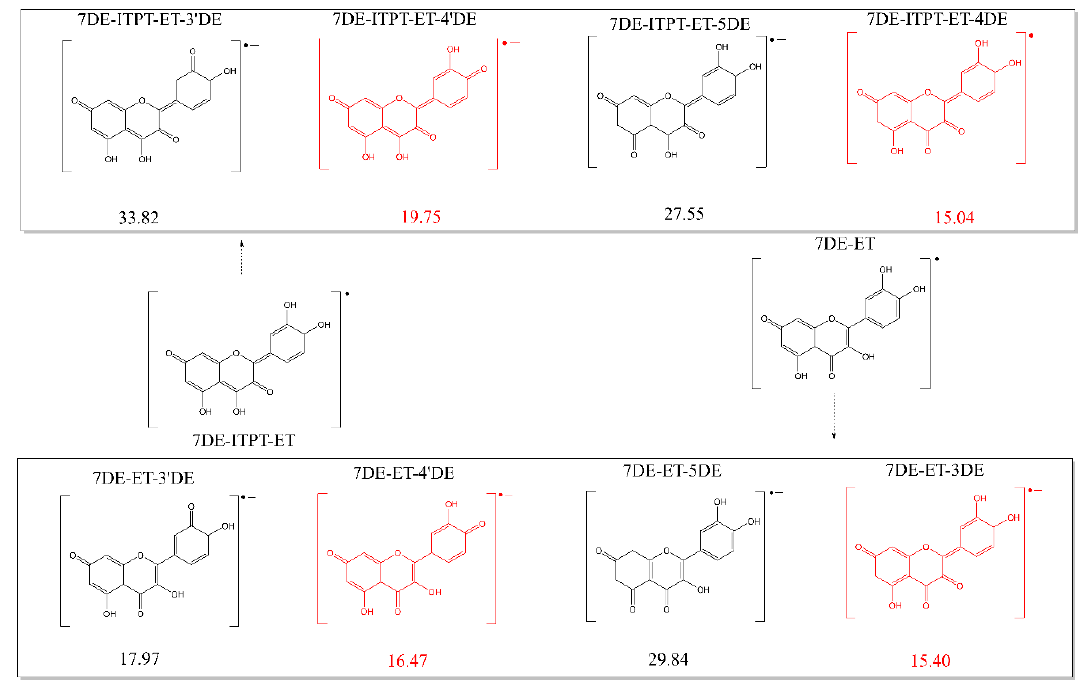
Figure 5. The enthalpy requirement of the deprotonation of the two conformers of the Q radical, 7DE-ET and 7DE-ITPT-ET. The four products in red are the products formed out of both Q radical conformers by deprotonation (proton transfer) of their 3-OH or 4 ′ -OH group, and the formation of these products appeared to require the lowest reaction enthalpy.